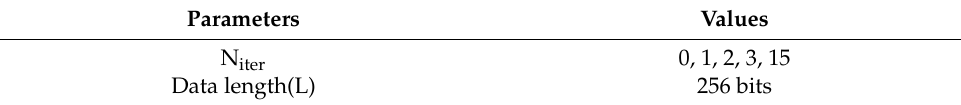
Figure 2. Performance of CRDSA. Table 1. Simulation parameters of